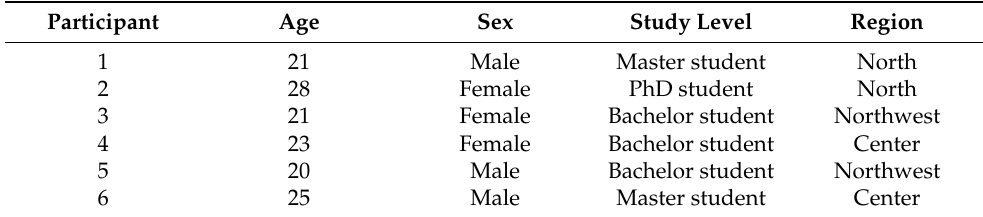
Table A1. Sociodemographic characteristics of the comprehensibility test